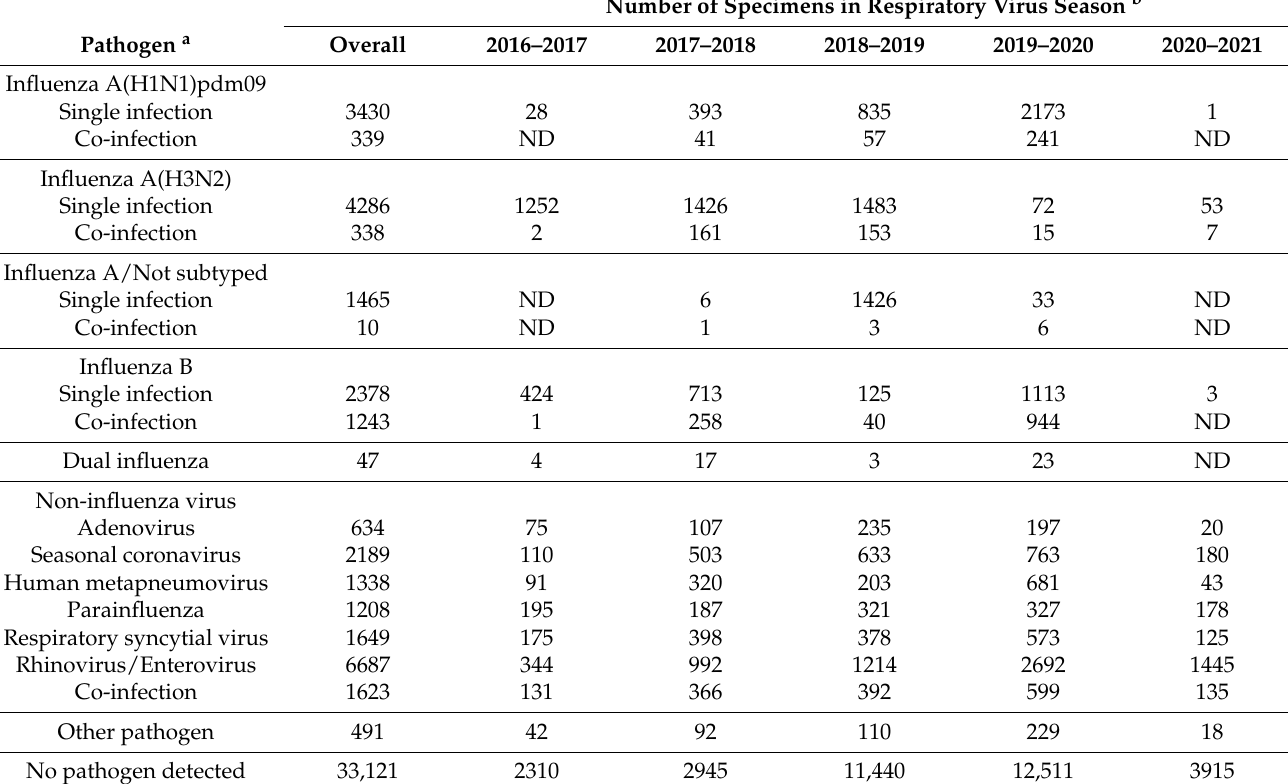
Table 1. Influenza and other seasonal respiratory viruses detected over five respiratory seasons